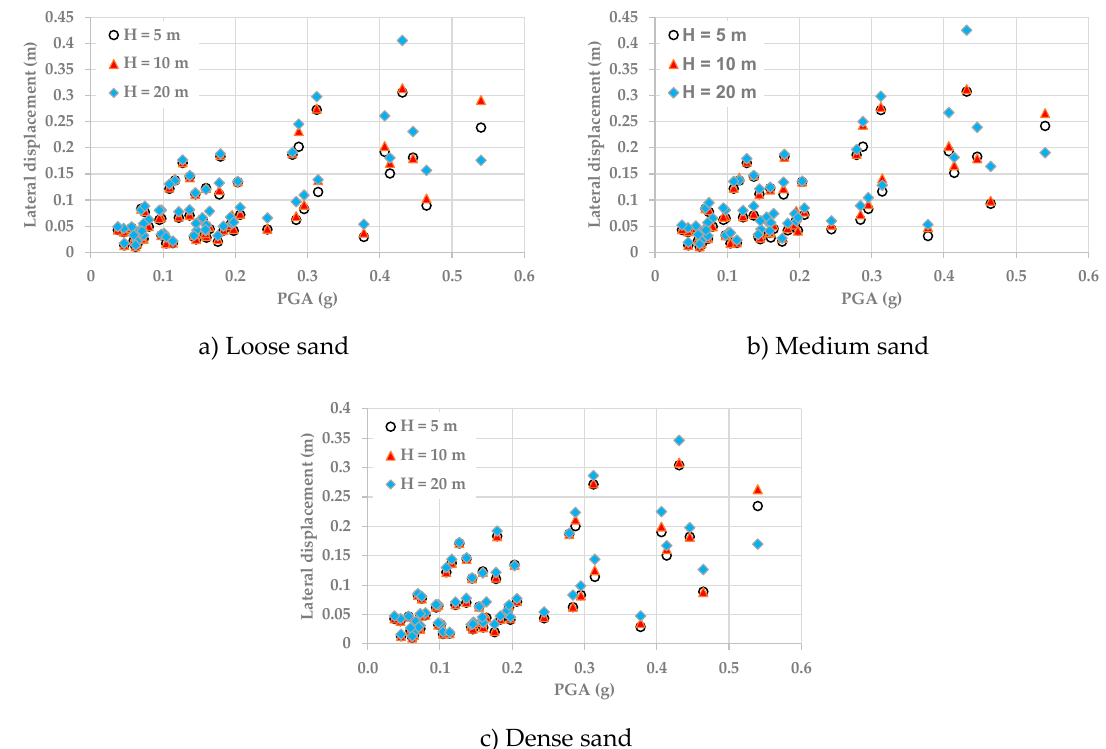
Figure 10. Effect of the thickness of the liquefiable layer on the lateral displacement of the building.